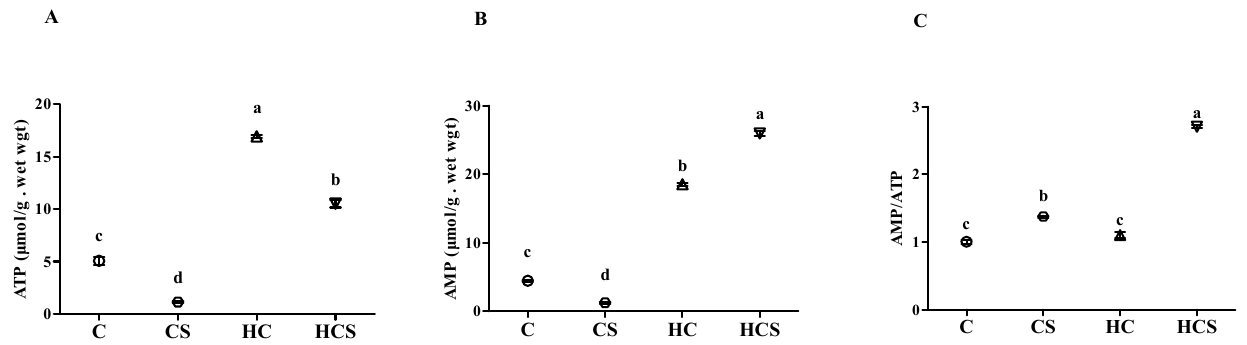
Figure 3. Hepatic ATP ( A ) and AMP ( B ) contents and the AMP/ATP ratio ( C ) of M. amblycephala subjected to different treatments. ATP, adenosine triphosphate; AMP, adenosine monophosphate. Each data point represents the mean ± SEM of four replicates. Bars assigned different superscripts (a, b, c and d) are significantly different ( p < 0.05).